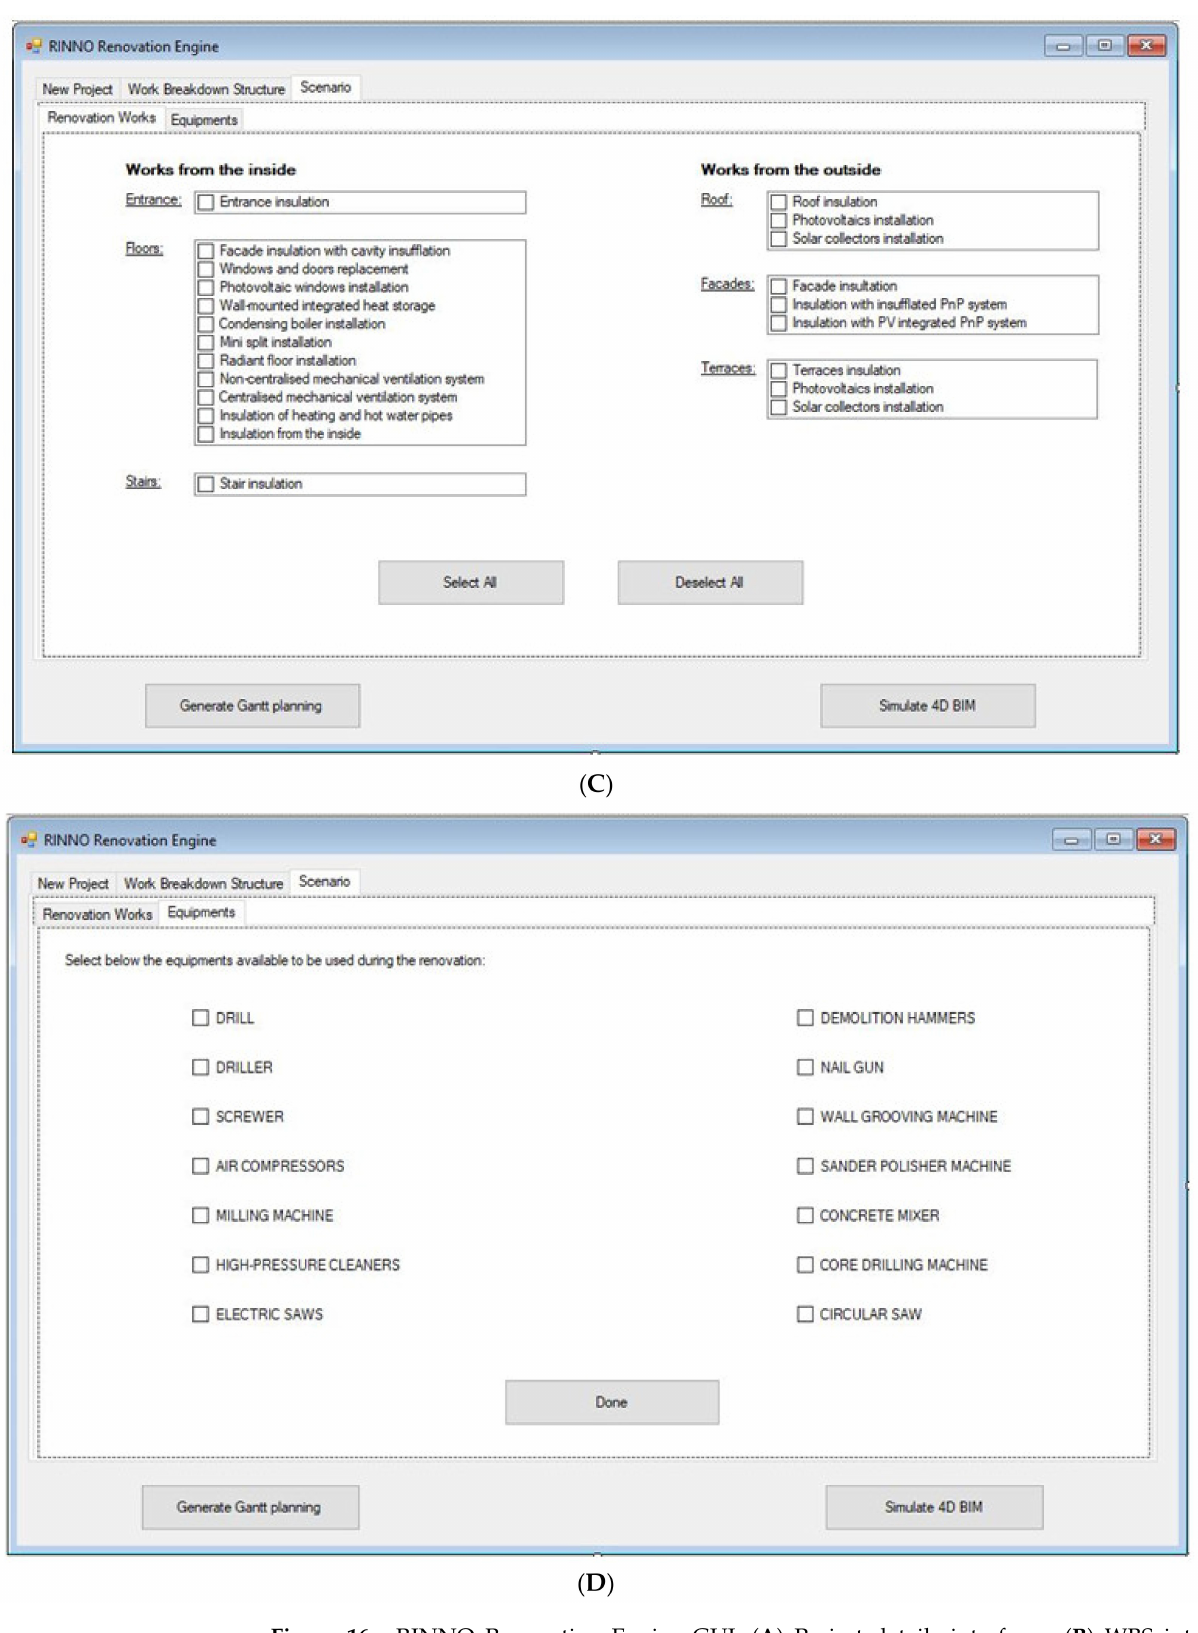
Figure 16. RINNO Renovation Engine GUI. ( A ) Project details interface. ( B ) WBS interface. ( C ) Scenario interface 1 for renovation activities selection. ( D ) Scenario interface 2 for renovation equipment